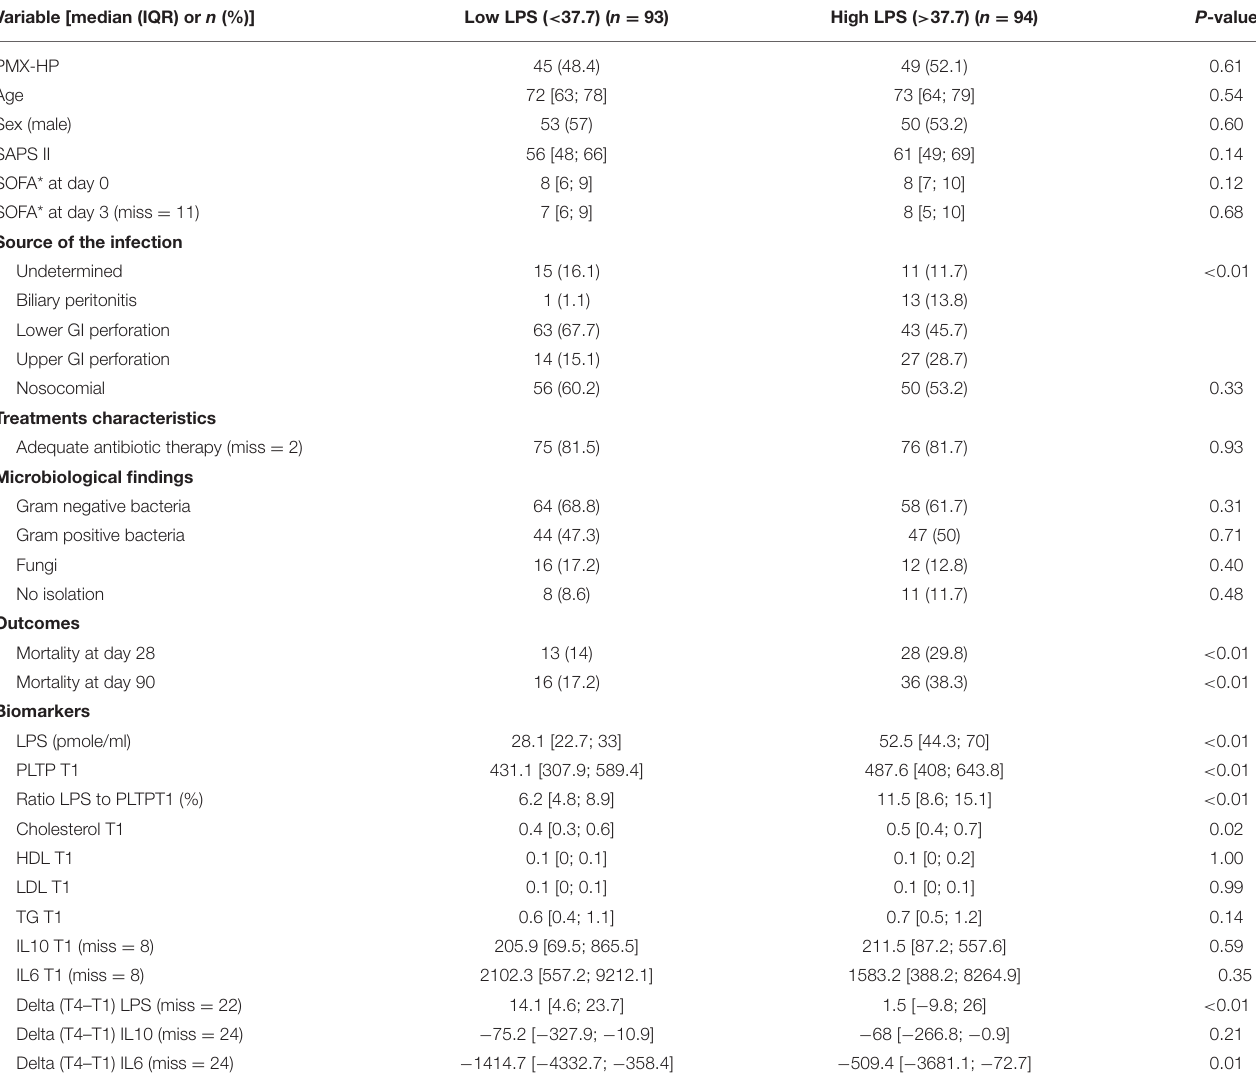
TABLE 1 | Comparison between patients with low (lower median value) vs. high (higher median value) of LPS at T1 (baseline) ( n = 187). Variable [median (IQR) or n